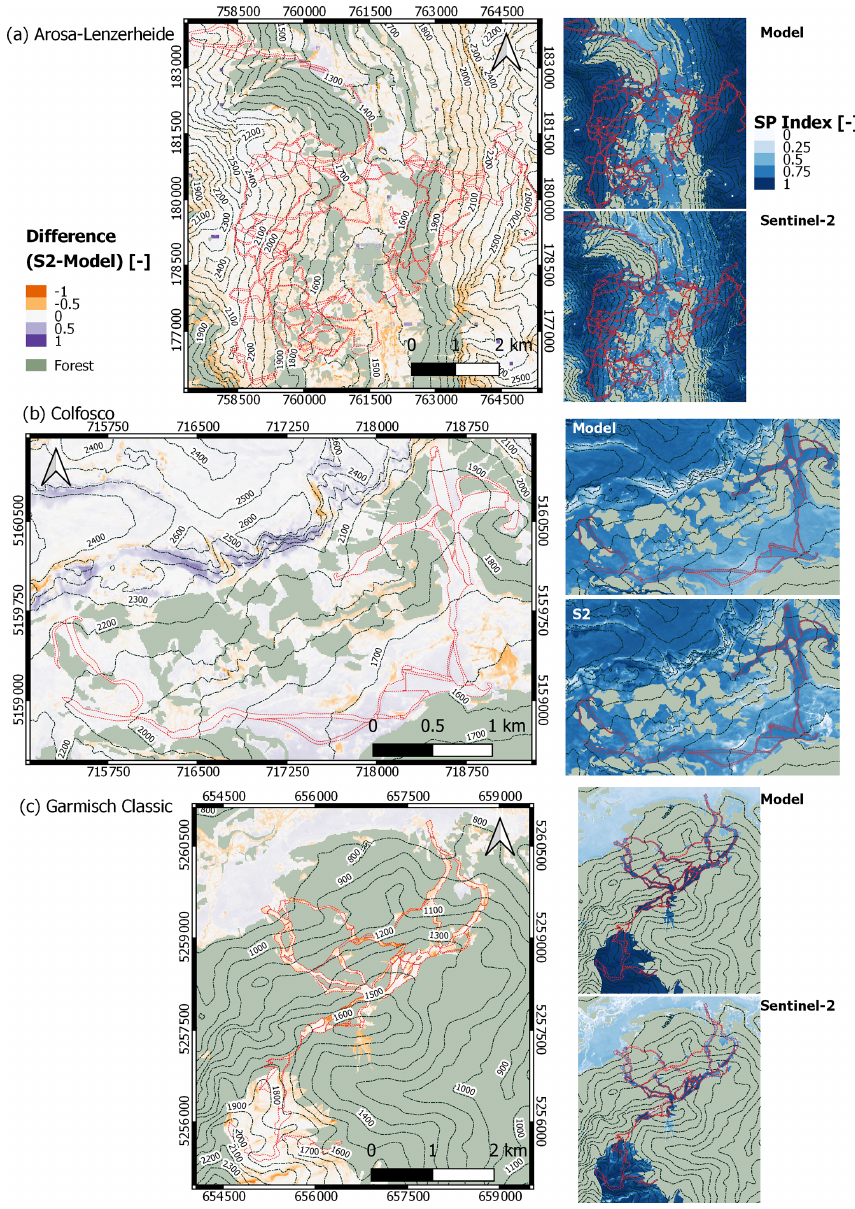
ferences are shown in Fig. 3. The green pixels indicated the applied forest mask to minimize the underestimation of snow detection by the S2 algorithm. Observed SP presented simi- lar patterns for each ski resort, showing that snow persistence patterns were primarily controlled by the elevation. High el- evation corresponds to high SP values, whereas low SP val- ues were found near the tree line and at lower